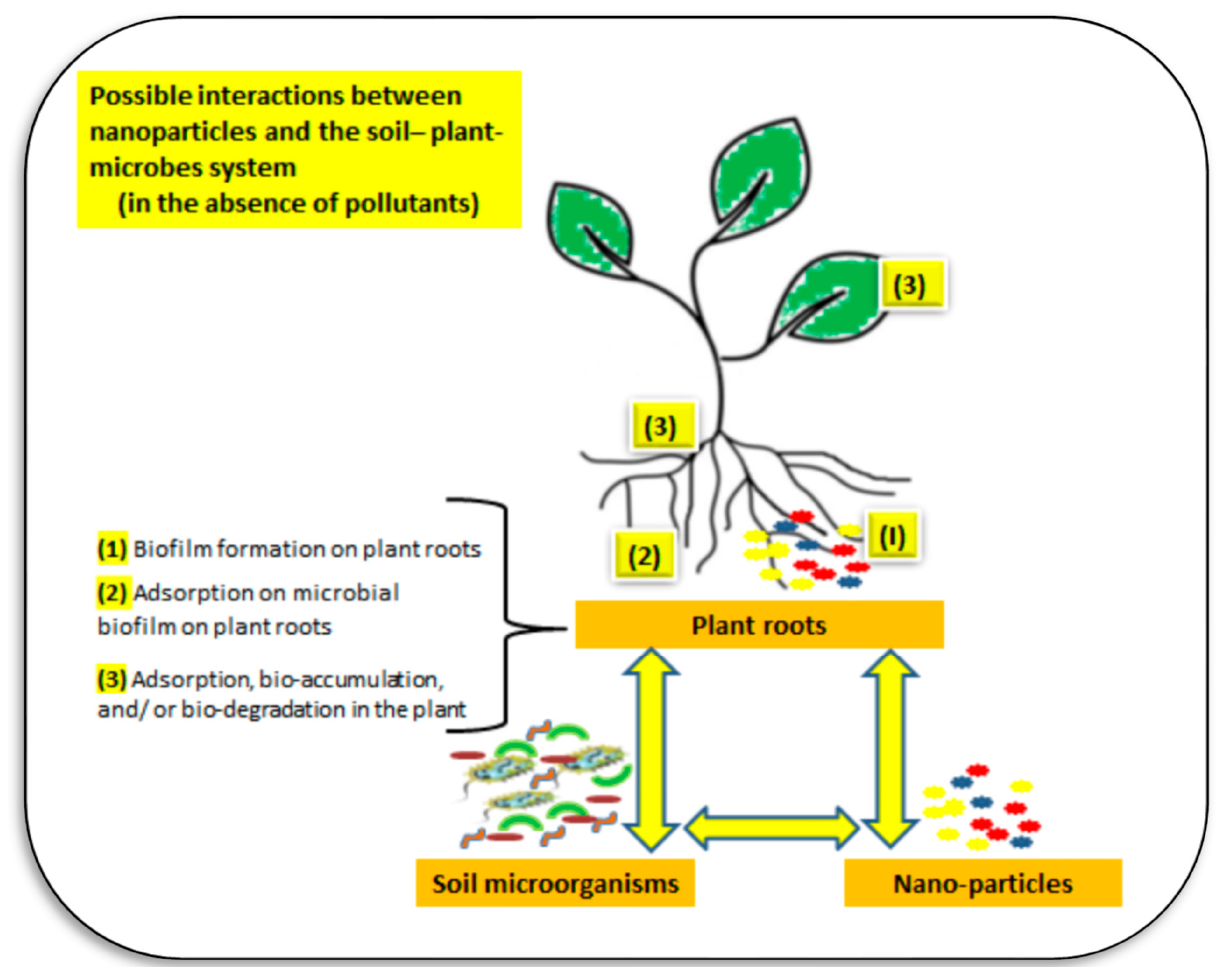
Figure 18. The interactions between soil microbes, plants, and nanoparticles involve pathways in the soil like forming biofilms on plant roots, adsorption, and bio-degradation in plants, but many mechanisms are still unknown and need more investigation. Sources: [118,122–124].